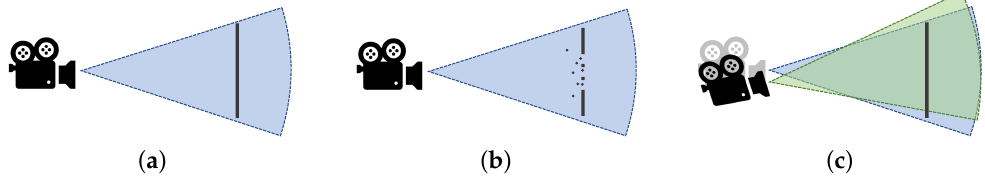
Figure 1. Illustration of the sensor noises. ( a ) Sensor without noises. ( b ) Depth noises. ( c ) Sensor pose noises.